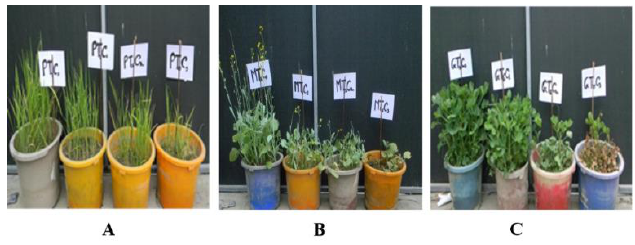
Figure 1: Comparison among control, 0.25%, 50%, and 1% concentrations of Siam weed debris on seedling growth of (A) rice, (B) mustard and (C) groundnut. PTC0 = Control (no plant debris of Siam weed), PTC1 = 0.25% concentration of Siam weed debris, PTC2 = 0.50% concentration of Siam weed debris and PTC3 = 1% concentration of Siam weed debris.